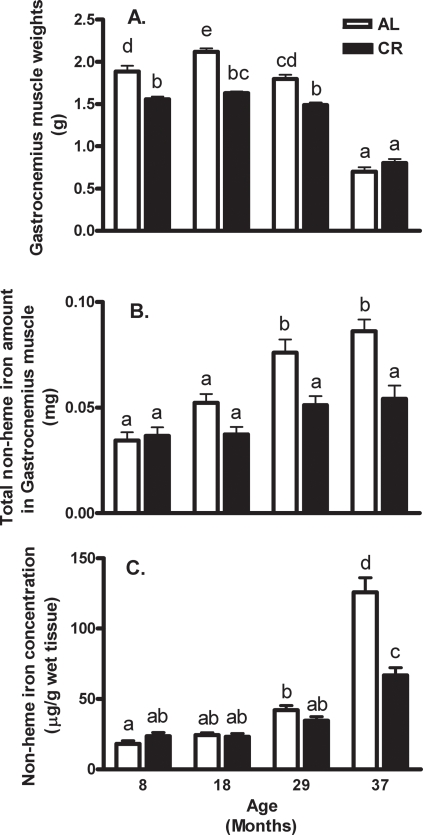
Effect of aging and calorie restriction on gastrocnemius weights and non-heme iron content.(A) Gastrocnemius muscle weights from ad libitum-fed and calorie-restricted rats at 8, 18, 29, and 37 months of age. (B) Total non-heme iron content of gastrocnemius muscle was calculated from non-heme iron concentrations and muscle weights. (C) Non-heme iron concentrations were measured colorimetrically after acid digestion of tissue. Values are means±SEM (n = 8–9). a,b,c,dDifferent letters indicate values are significantly different (p<0.05 by Tukey's Multiple Comparison Test).